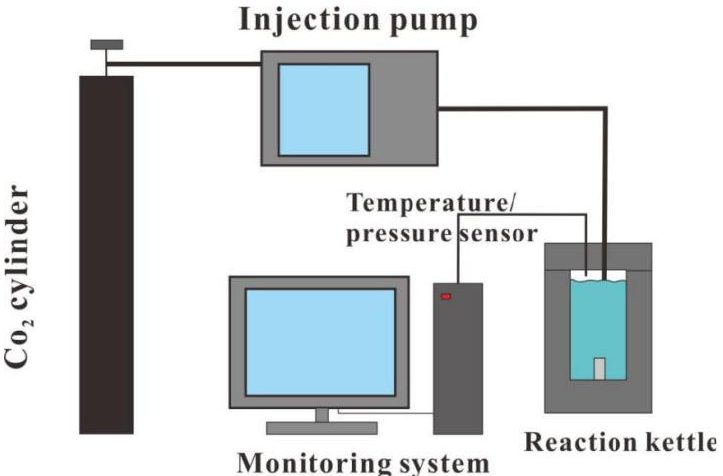
Figure 3. The fluid-rock reaction test system with high temperature and high pressure. Table 2. Experimental conditions in the comparative stimulation.